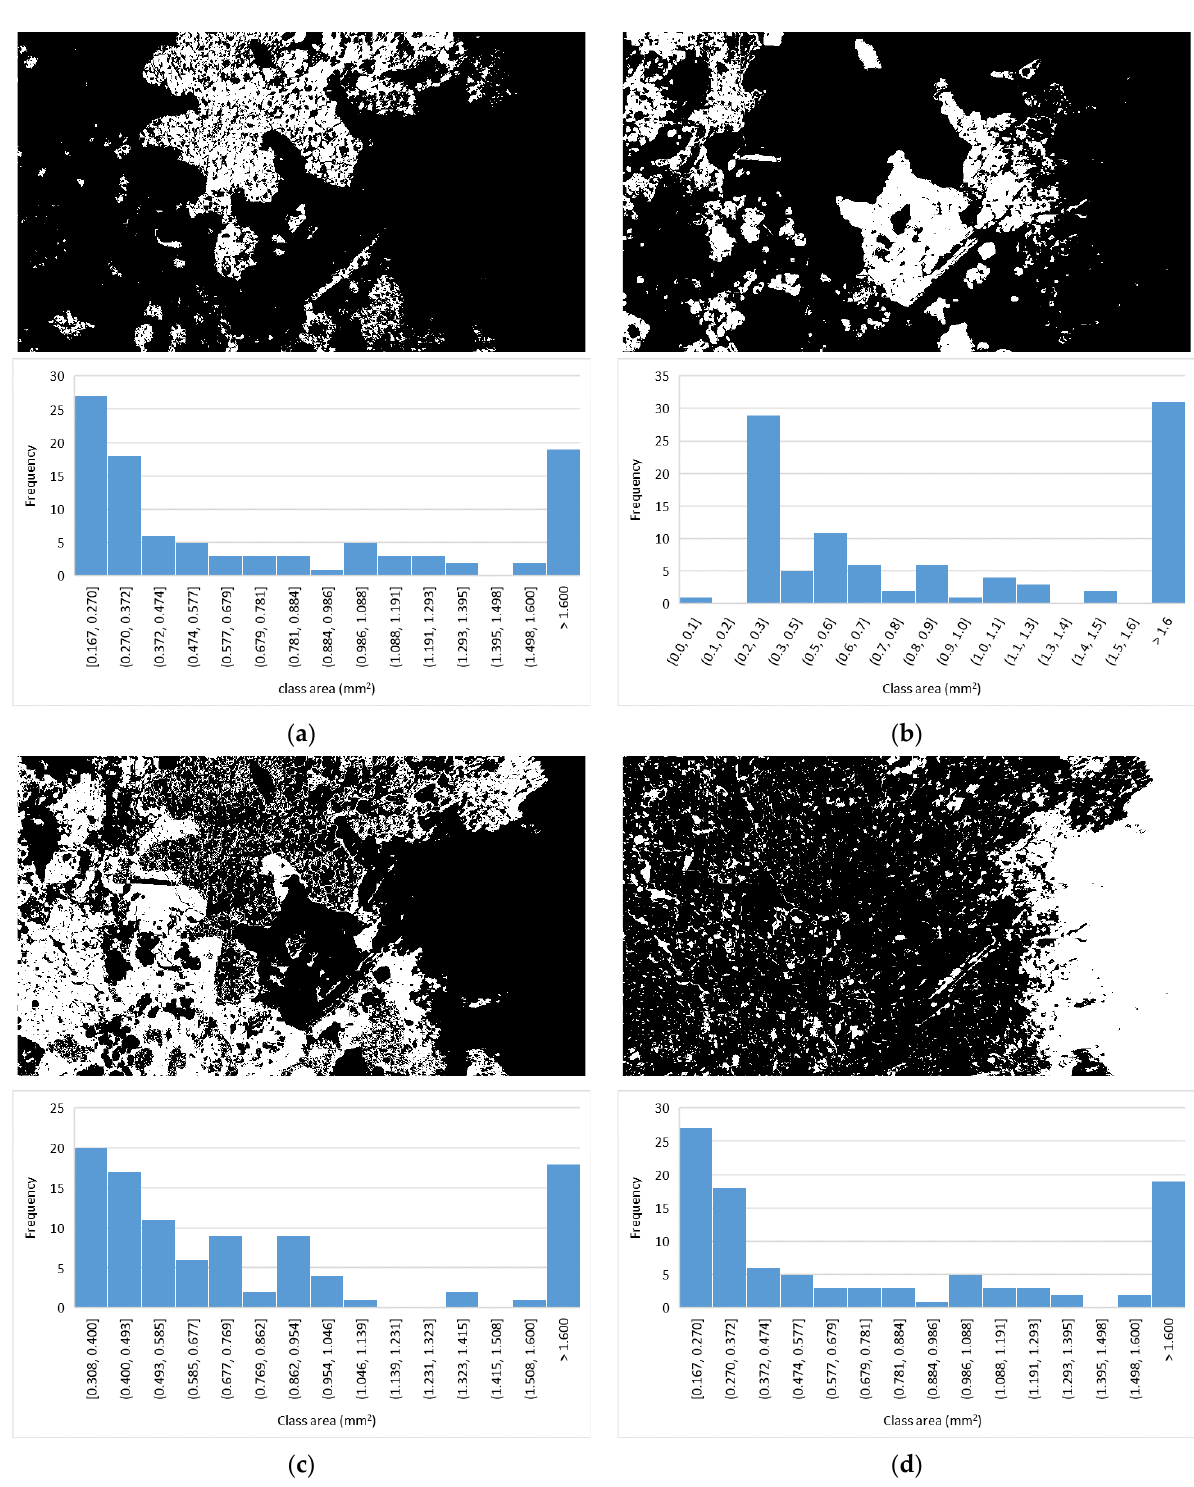
Figure 10. Segmented areas and their histograms from the grain size distribution algorithm. ( a ) Seg 1 Eq. Area (mm 2 ); ( b ) Seg 2 Eq. Area (mm 2 ); ( c ) Seg 3 Eq. Area (mm 2 ); ( d ) Seg 4 Eq. Area (mm 2 ).